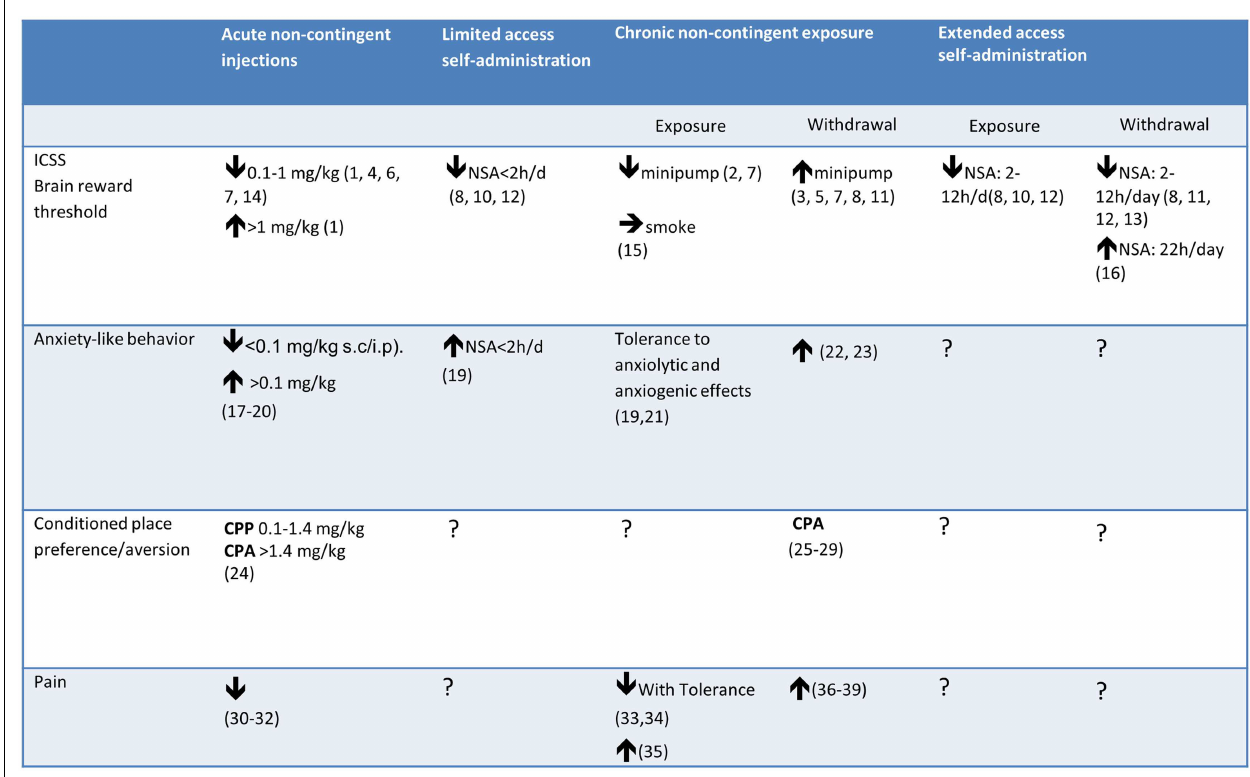
(2008), 12. Paterson et al. (2008), 13. Bruijnzeel et al. (2009), 14. Spiller et al. (2009), 15.Yamada et al. (2010) 16. Harris et al. (2011); 17. Brioni et al. (1993); 18. Irvine et al. (1999), 19. Irvine et al. (2001), 20.Tucci et al. (2003); 21. Biala and Budzynska (2006), 22. Stoker et al. (2008), 23. Cippitelli et al. (2011), 24. Le Foll and Goldberg (2005), 25. Miyata et al. (2011), 26. Suzuki et al. (1996), 27. Shram et al. (2008), 28. Grieder et al. (2012), 29. Grieder et al. (2010), 30. Damaj et al. (1994), 31. Sahley and Berntson (1979), 32. Craft and Milholland (1998), 33.Yang et al. (1992), 34. Galeote et al. (2006), 35. Lough et al. (2007), 36. Grabus et al. (2005), 37. Jackson et al. (2008), 38. Schmidt et al. (2001), 39.Yang et al.